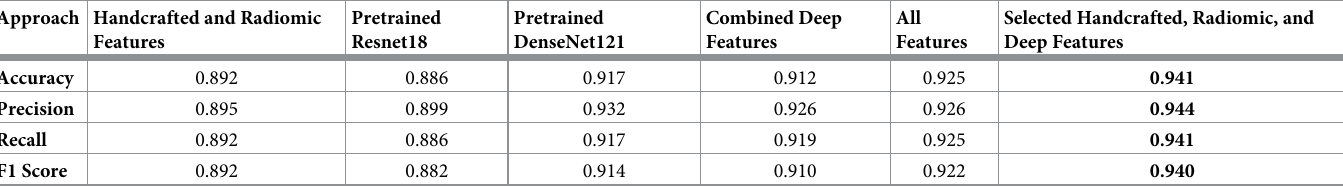
Table 2. Best classification metrics for each feature-level approach.